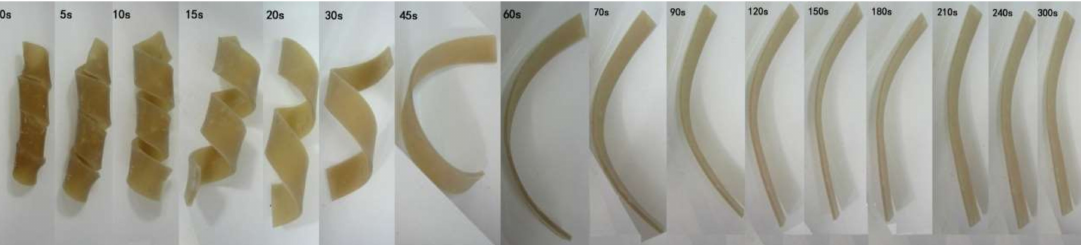
Figure 10. Shape recovery of AO-80/ACM rubber composites from a spiral-shaped temporary shape to stretched strip in water at 20 ◦ C, which is higher than T g .